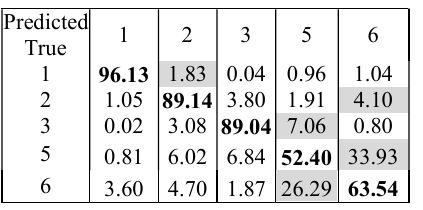
Table 11. Confusion matrix normalized by reference (in %) showing the classification result for feature set